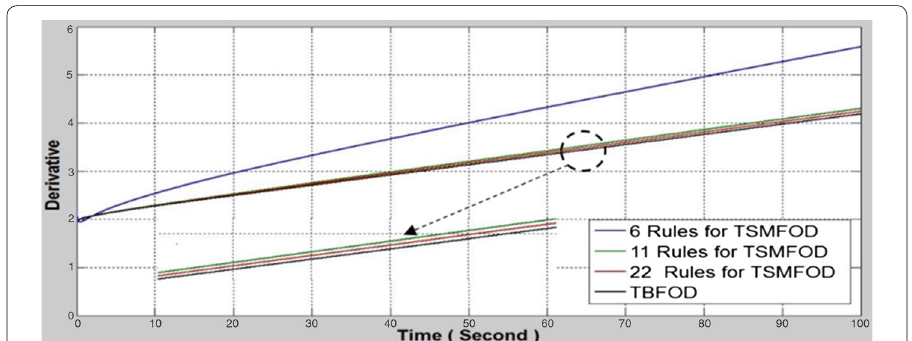
Fig. 10 Ramp dynamic response of TSMFOD and